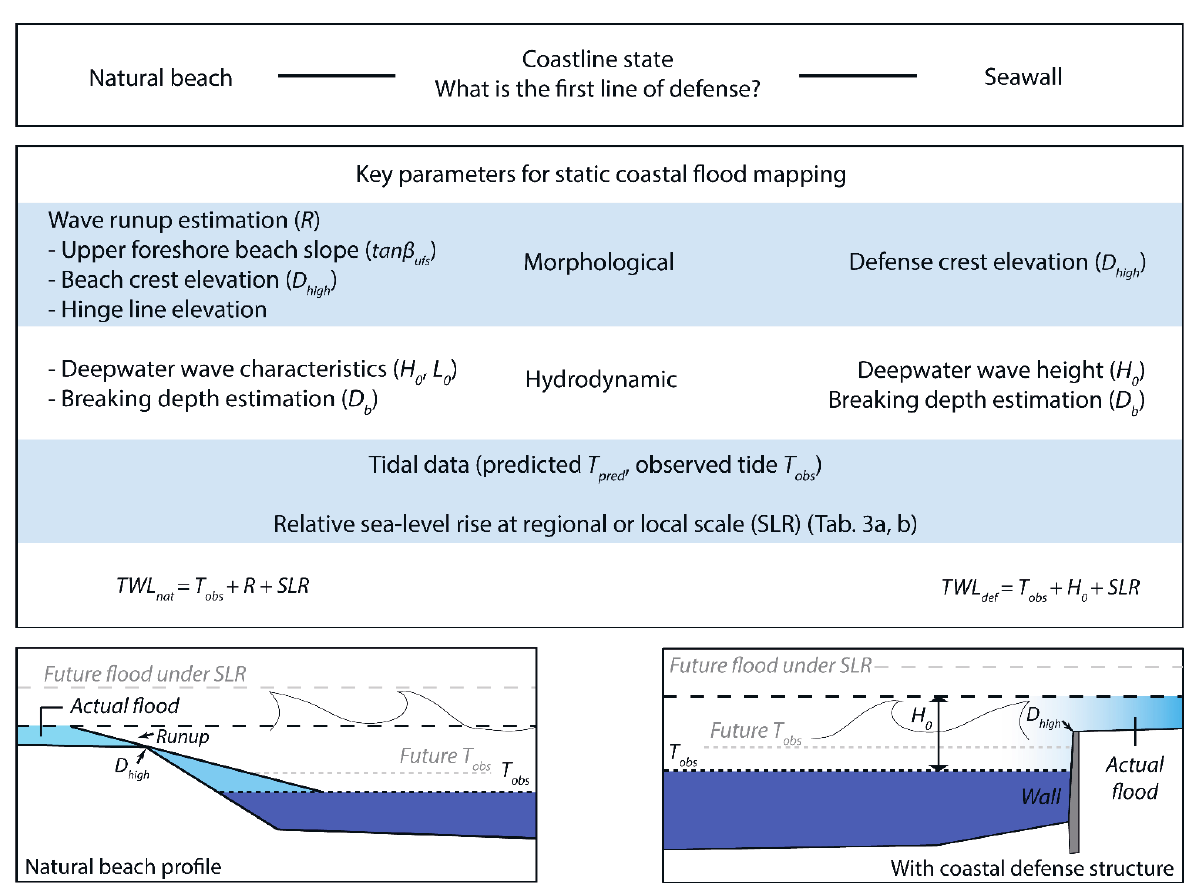
Figure 13 . Conceptual and methodological approach for the static coastal flood